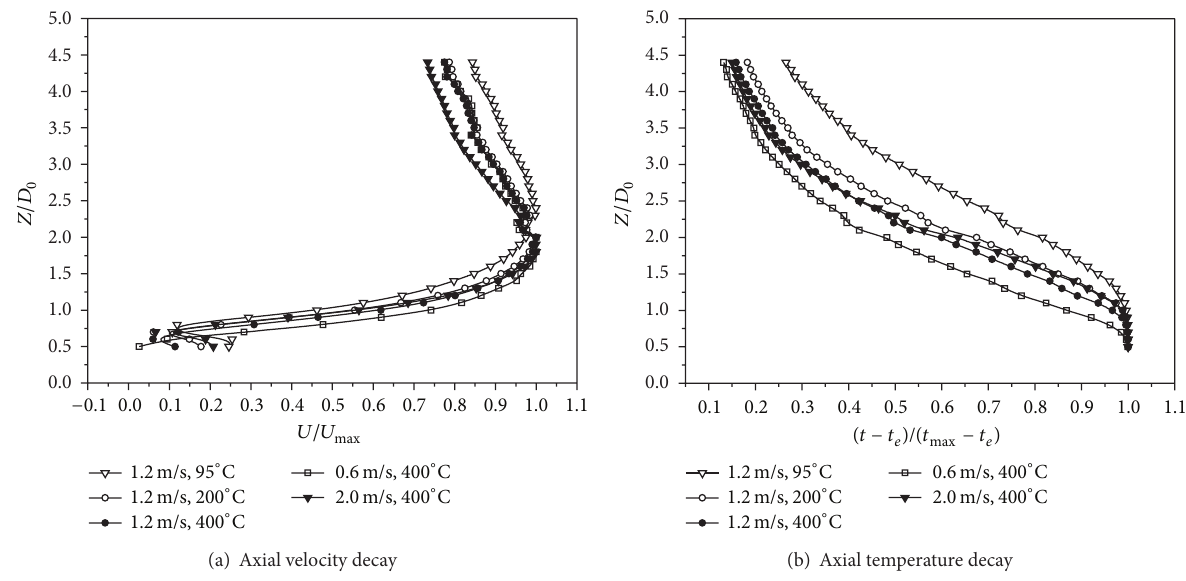
Figure 7: Comparison of axial velocity and temperature decay with different initial parameters of annular buoyant jets.